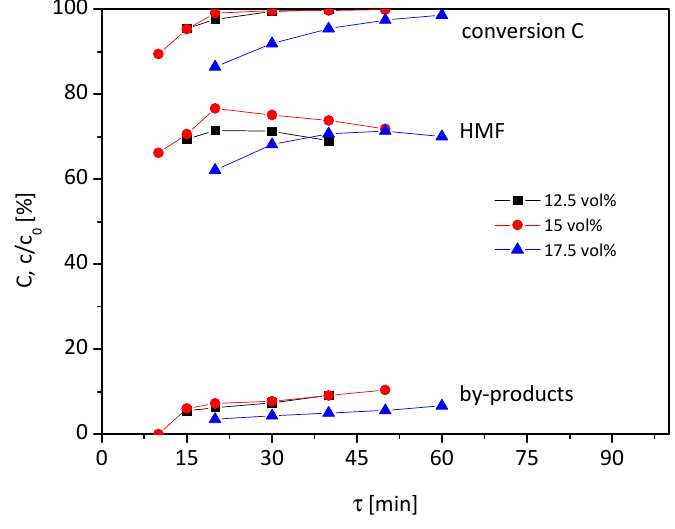
Figure 3. Influence of water content on conversion, HMF yield and by-products (0.1 M fructose, 100 °C, 12.5–17.5 vol% H 2 O in HFIP, 1.7 g Lewatit K2420 catalyst bed).